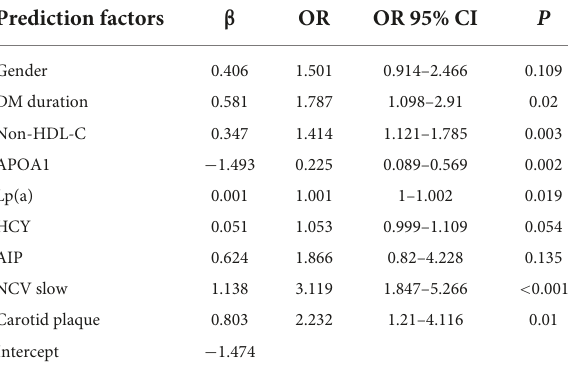
TABLE 2 Model established by logistic regression analysis based on the training